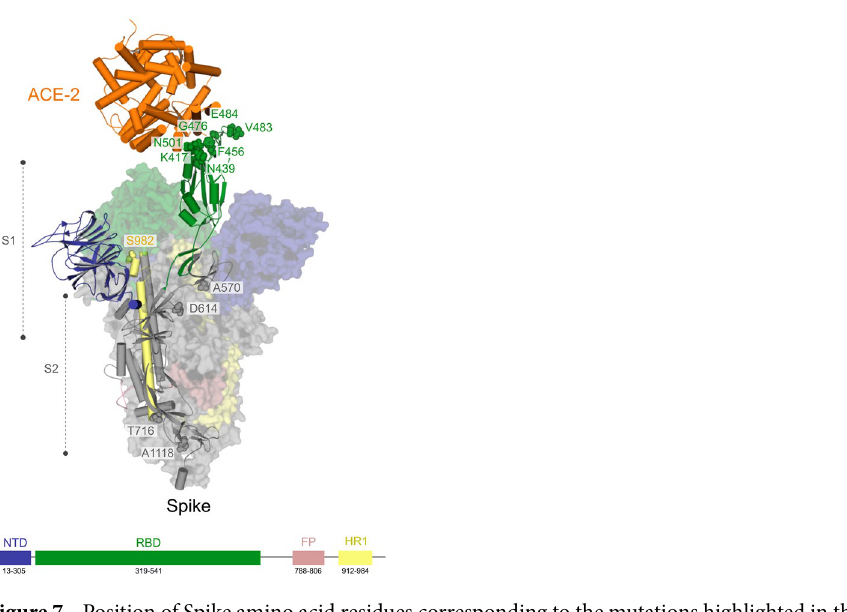
Figure 7. Position of Spike amino acid residues corresponding to the mutations highlighted in this study. Amino acid residues in the RBD (green) and outside of RBD (gray and light brown) mapped onto a structure of SARS-CoV-2 Spike determined by electron microscopy (PDB code 7DF4). For this analysis, only the mutations with those residues falling into RBD were considered. Critical residues outside of RBD related to substitutions: D614G, P681H, T716I, S982A, and D1118H, found in the variant VOC-202012/01, are